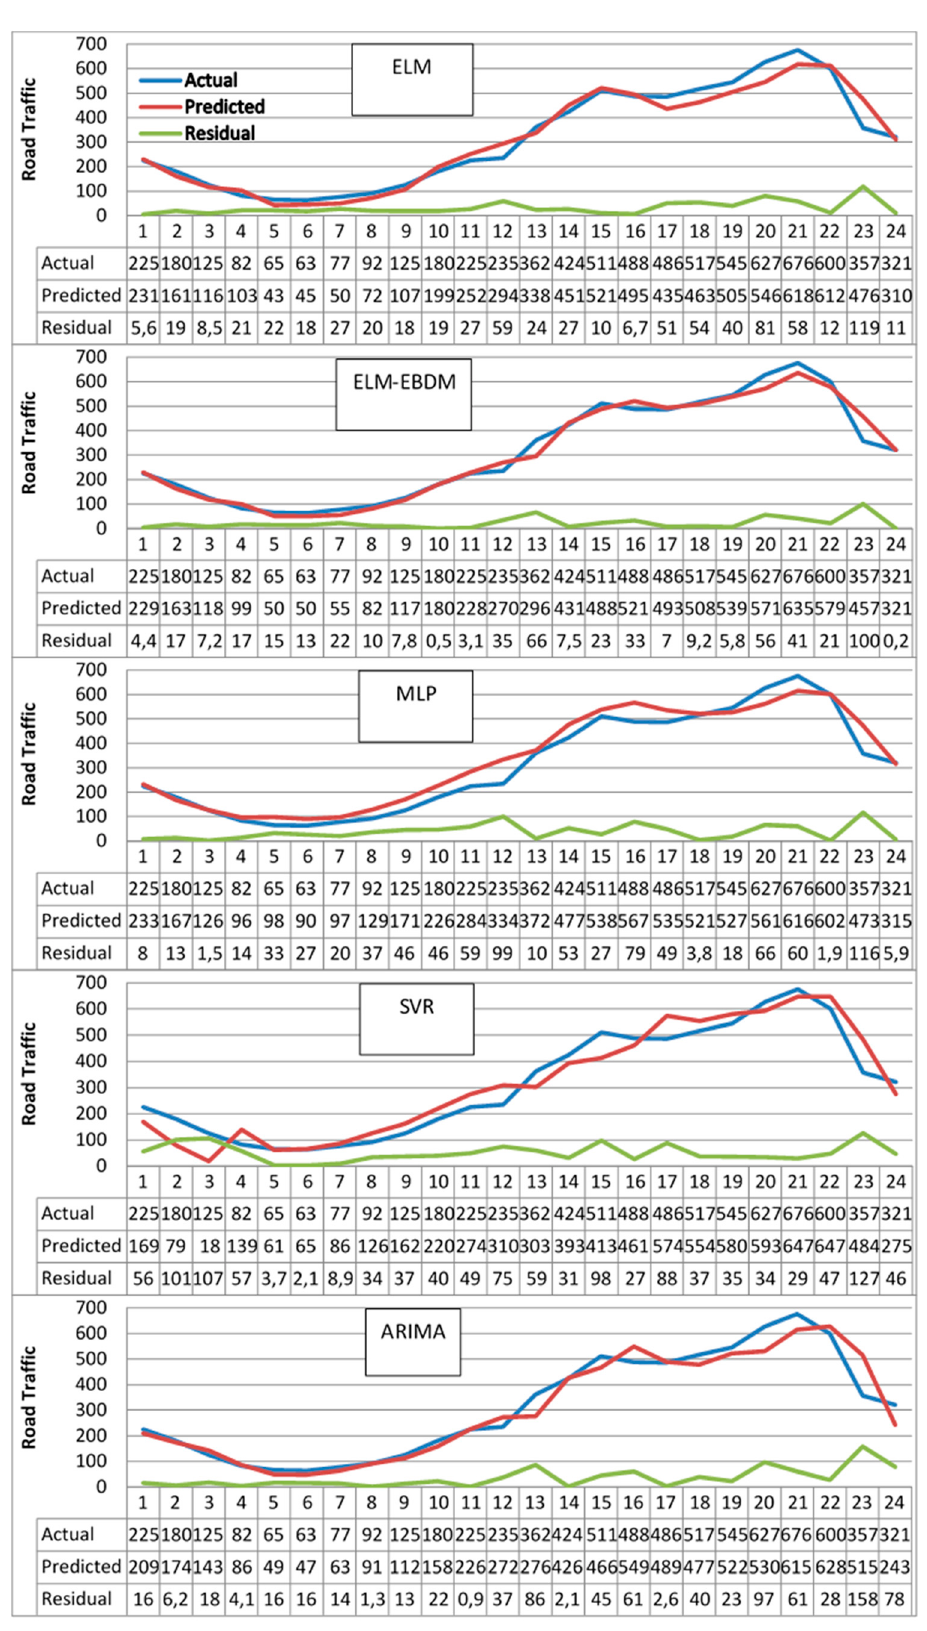
Figure 6. Traffic prediction results of different models. Figure 6. Tra ffi c prediction results of di ff erent